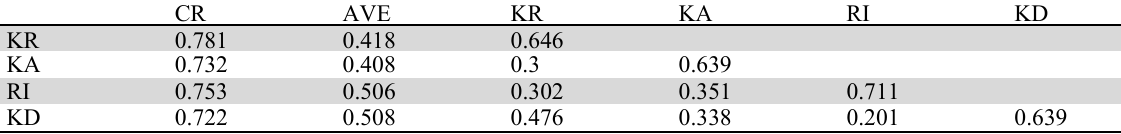
Composite reliability, Convergent and Discriminant validity CR